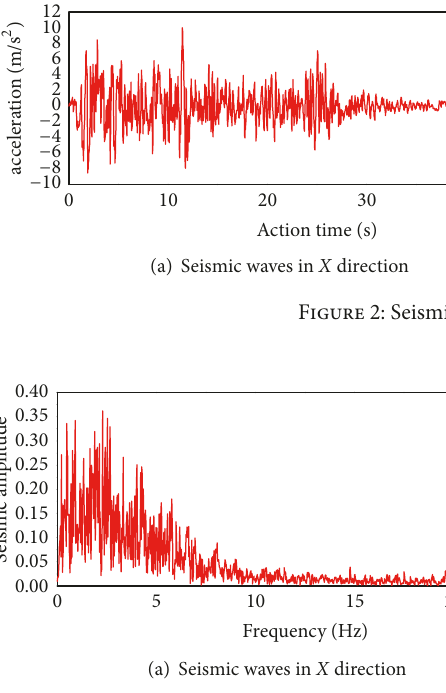
Figure 3: Seismic waves in frequency-domain in X and Y